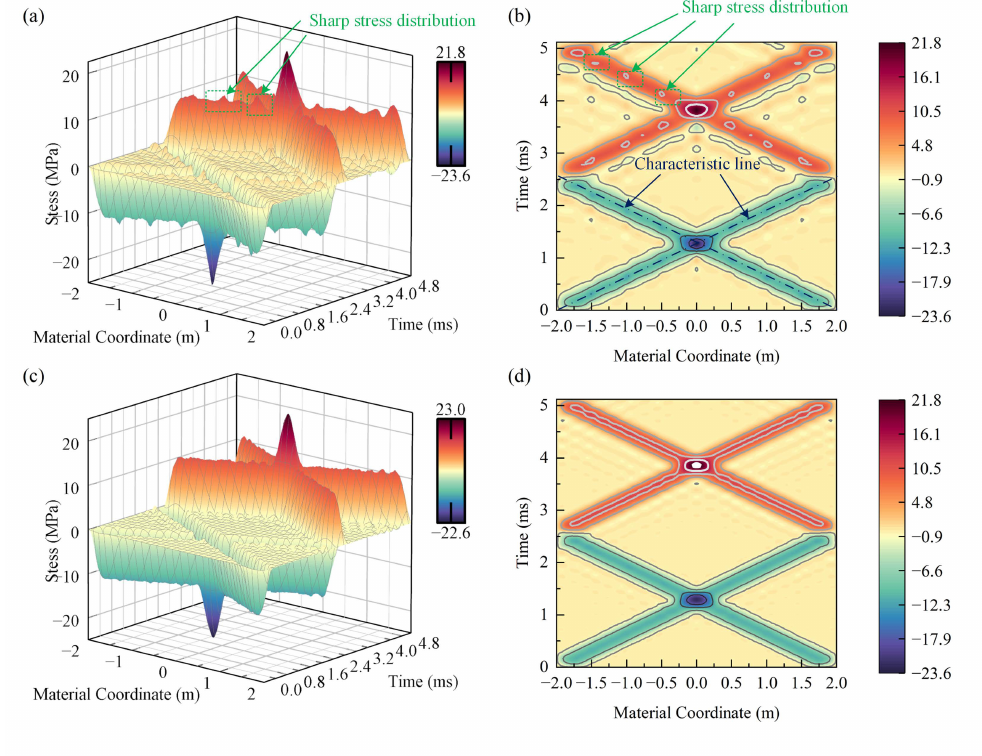
Figure 4. The transfer of longitude stress waves along the cable. ( a ) The 3D space-time stress distribution figure discretized by SAC-2 element. ( b ) The contour line figure of ( a ). ( c ) The 3D space-time stress distribution figure discretized by SAC-3 element. ( d ) The contour line figure of ( c